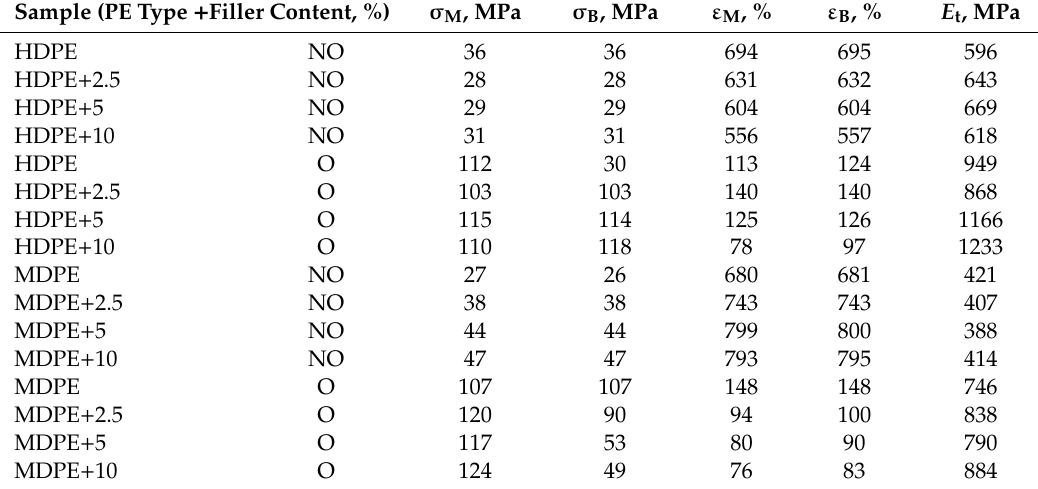
Table 2. Mechanical parameters of non-oriented (NO) and oriented (O) HDPE, MDPE and their composites with Sillikolloid ( σ M , maximal stress, σ B , stress at break, ε M , maximal elongation, ε B , elongation at break, E t , Young